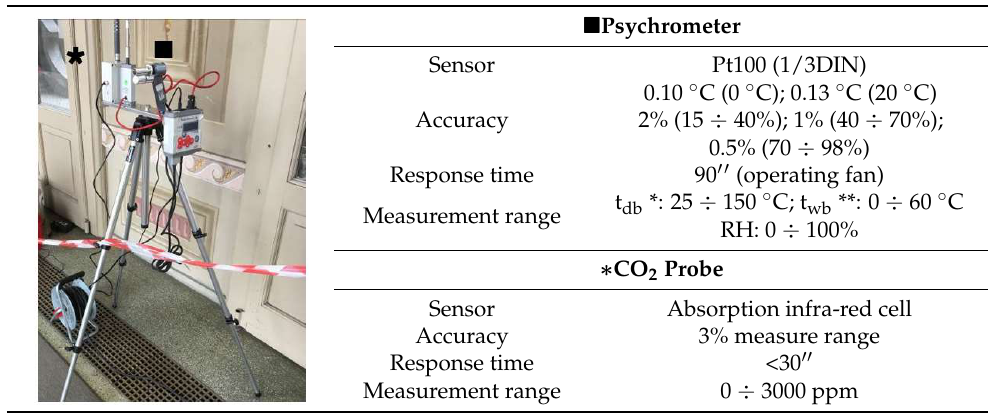
Table 6. Main features of the microclimate station.